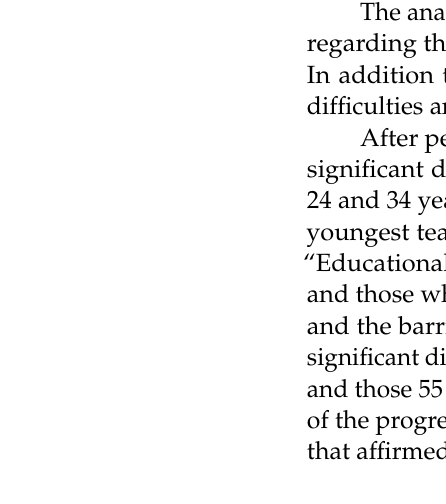
Table 5. Post hoc Kruskal-Wallis analysis according to the different age groups of teachers that are